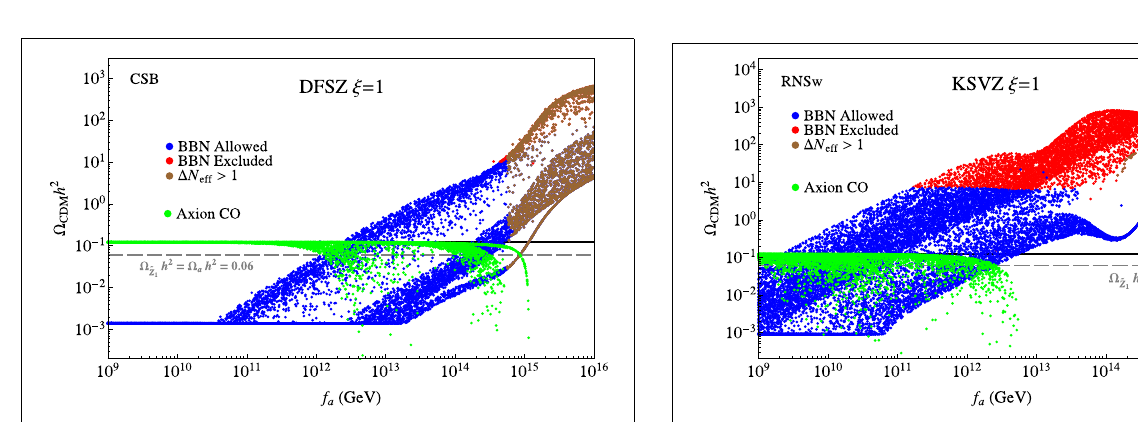
FIGURE 6 | The wino-like WIMP and axion relic densities from a scan over SUSY KSVZ parameter space for the RNSw benchmark case with ξ = 0 . The gray dashed line shows the points where DM consists of 50% axions and 50% neutralinos.